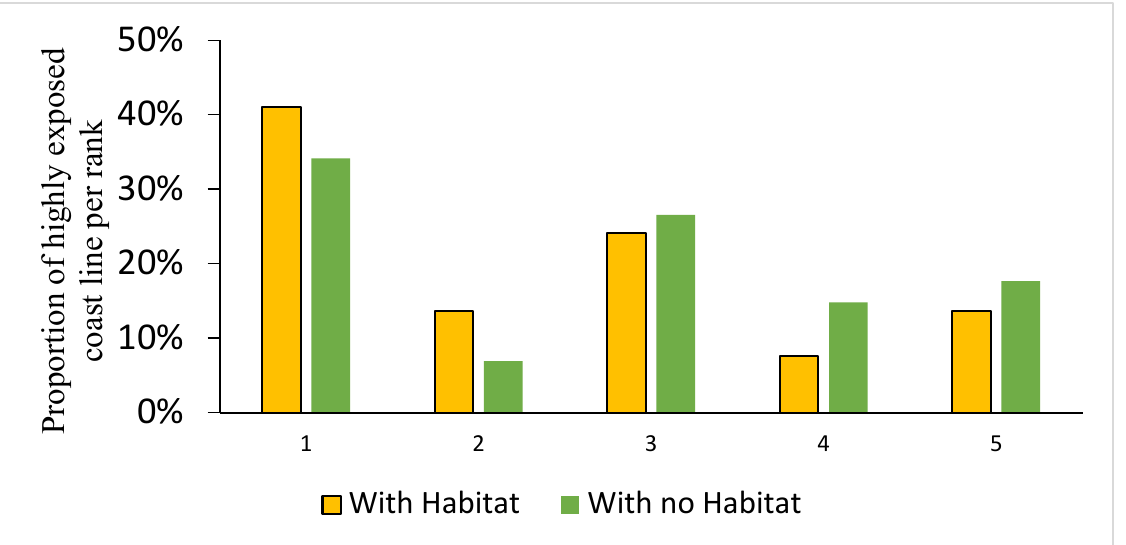
Figure 4. Percentage of habitat contribution to coastal hazards under the current scenario of SLR.